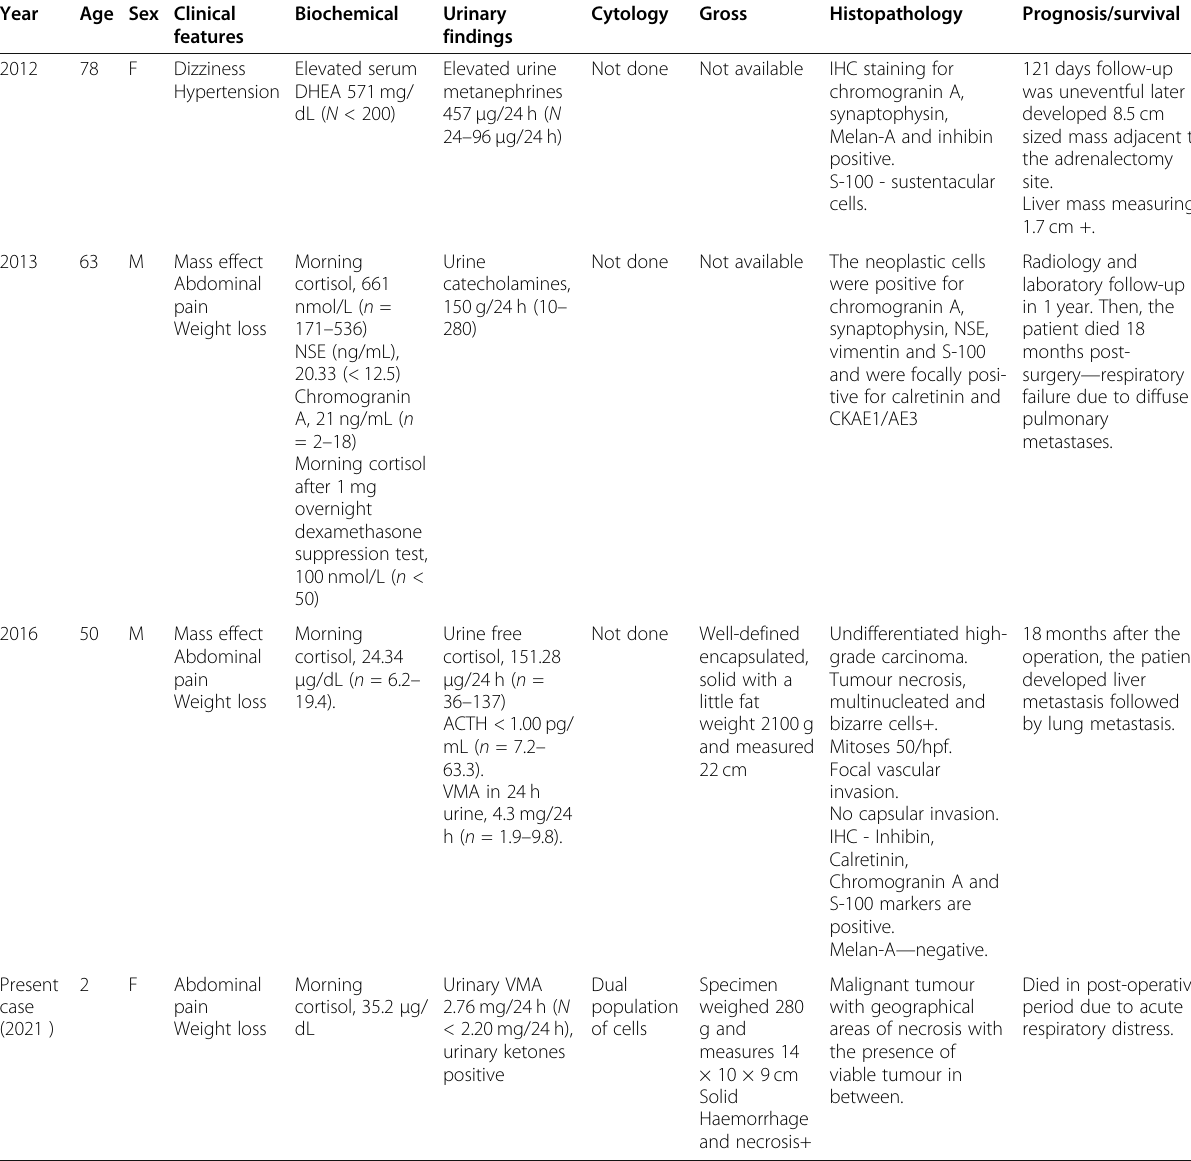
Table 1 Details of previously reported MCMA carcinoma along with a current case in the medical